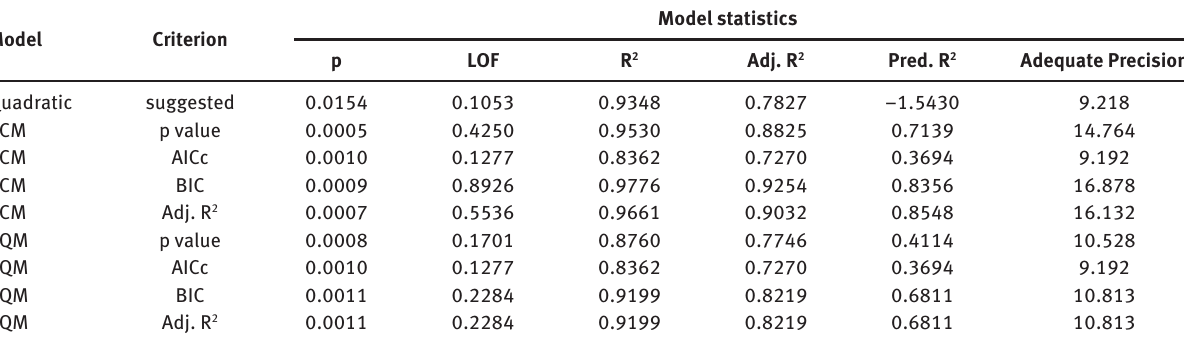
Table 4: Model reduction